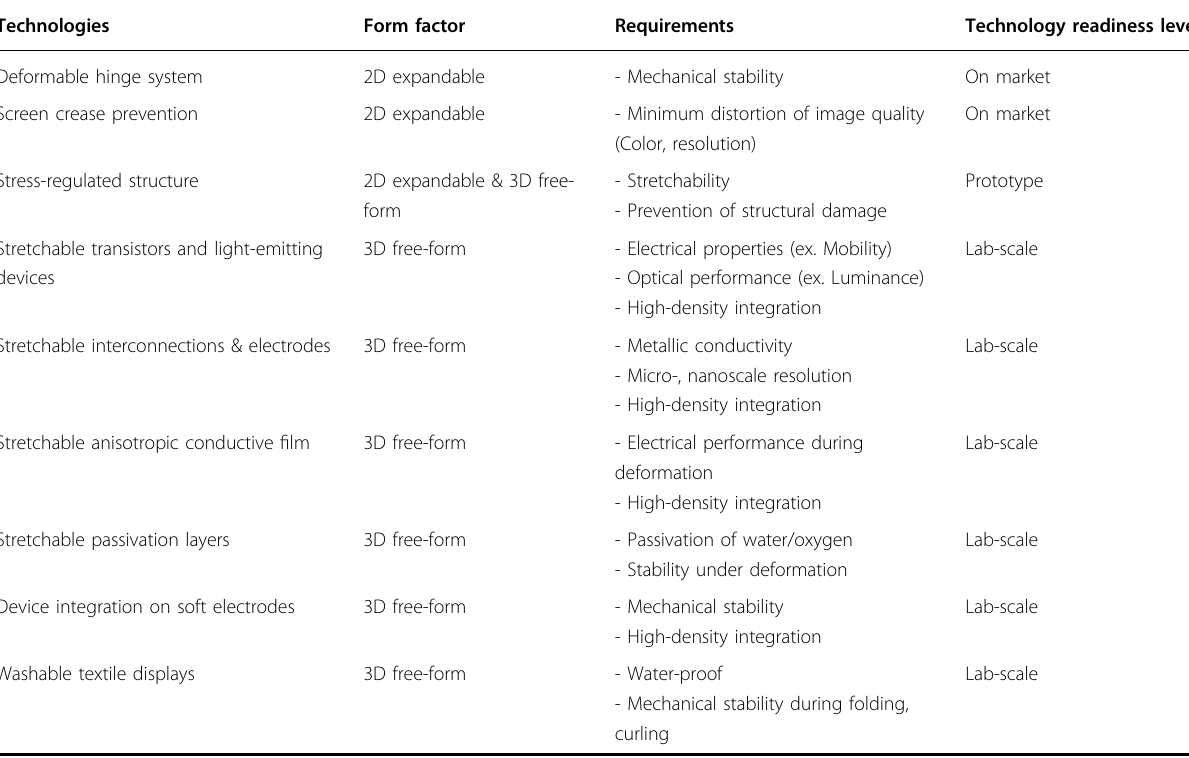
Table 1 Required technologies and assessments for the deformable displays